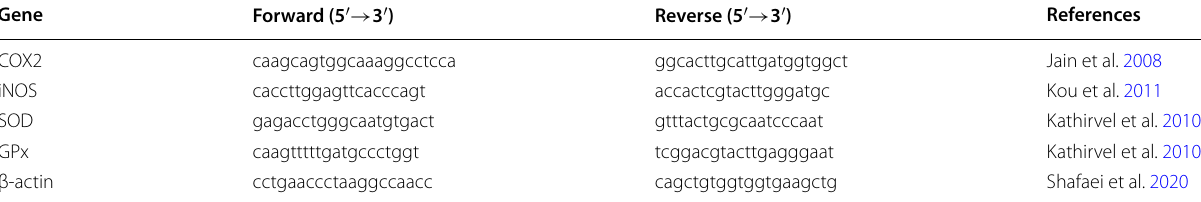
Table 7 The primer sets characteristics used in this study